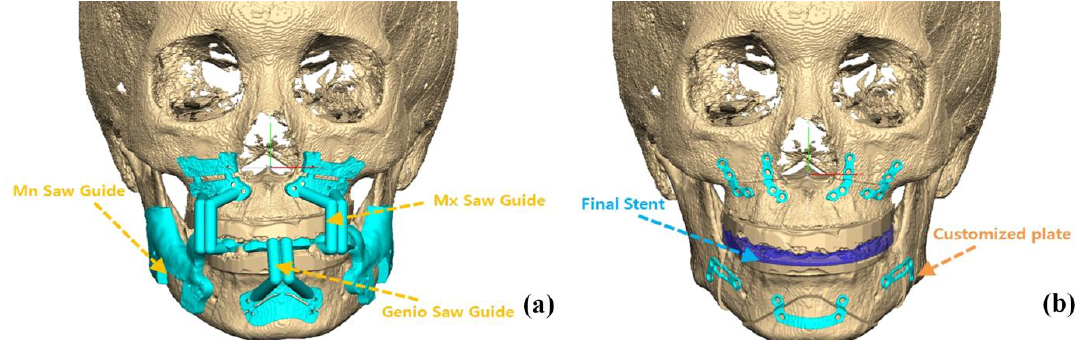
Figure 2. Virtual 3D skeletal images merged on scanned dental casts: ( a ) cutting guides for Le-Fort I osteotomy, BSSRO, and genioplasty, ( b ) dental arches were fit into the final splint, and customized plates were placed on repositioned bone fragments.